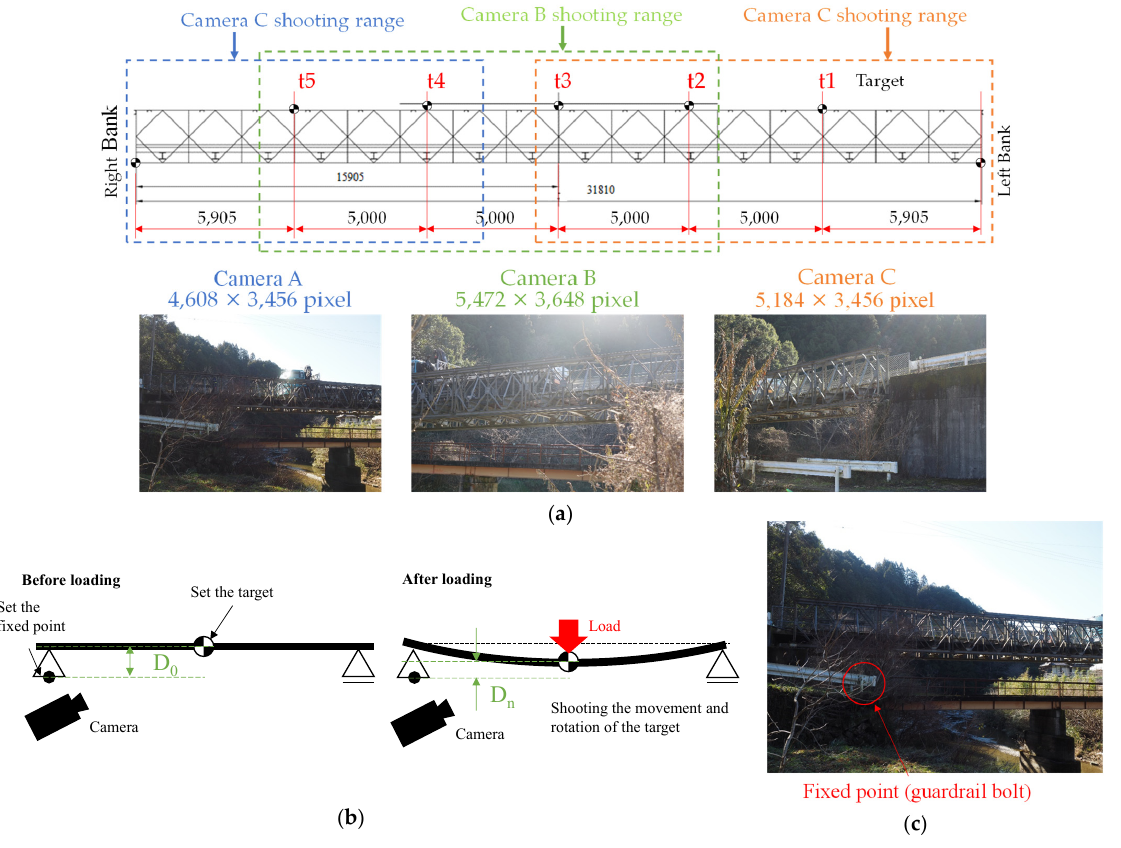
Figure 5. ( a ) Image processing setup, Targets are set at specific spots, and structural responses are determined from the recorded events. ( b ) Deflection determination was based on target/quadrant vs. fixed bolt relationship. ( c ) Preselected rigid reference point—the guard rail bolt.